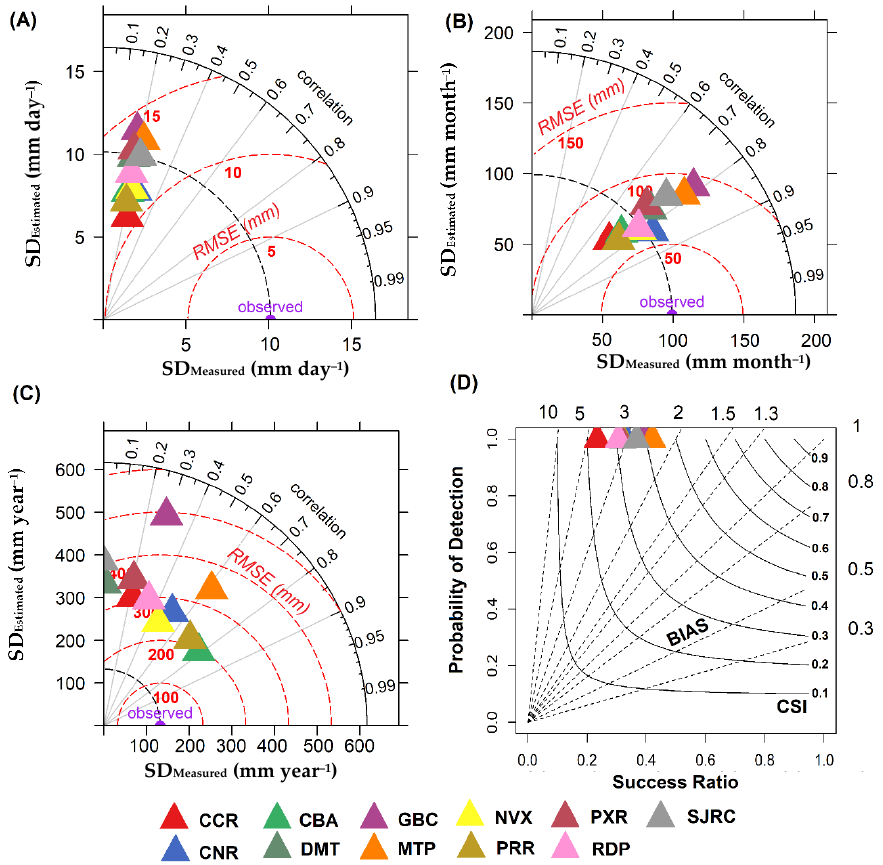
Figure 7. Taylor diagrams showing the comparisons of ( A ) daily (mm day −1 ), ( B ) monthly (mm month −1 ), and ( C ) annual (mm year −1 ) measured and estimated precipitation, as well as ( D ) the performance diagram of the MERRA product at each of the weather stations in the state of Mato Grosso, Brazil. In panels ( A – C ), the Pearson correlation coefficient (r) is represented by the azimuth angle (black outlines), the RMSE was represented by the red dashed outlines, and the standard deviation (SD) was indicated by on the x and y axes, respectively. In panel ( D ), the probability of detection (POD) is represented on the x and y axes; the BIAS was indicated by the dashed black lines; and the critical success index (CSI) was represented by continuous black lines. For ( A ), the daily values for the entire study period were averaged, while for ( B ), the total monthly values for all months during the study period were averaged, and the annual values in ( C ) were the annual values averaged for all years during the study period.